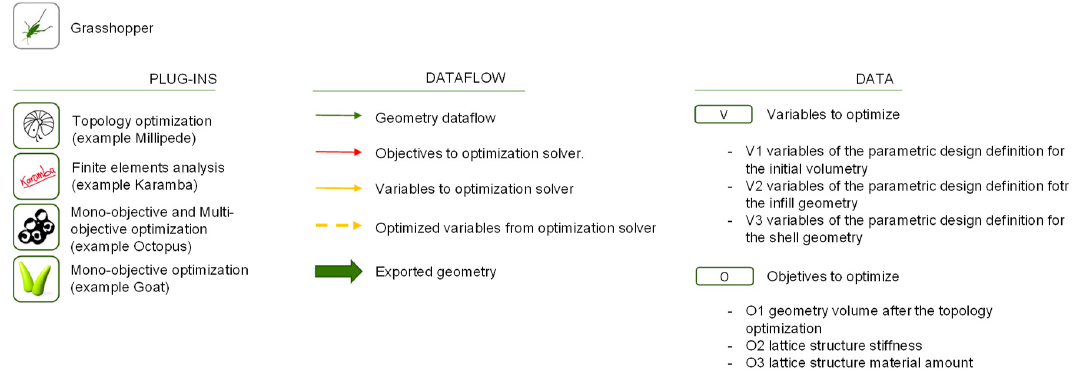
Figure 15. Legend of the symbols used in the diagrams of the different methodologies.